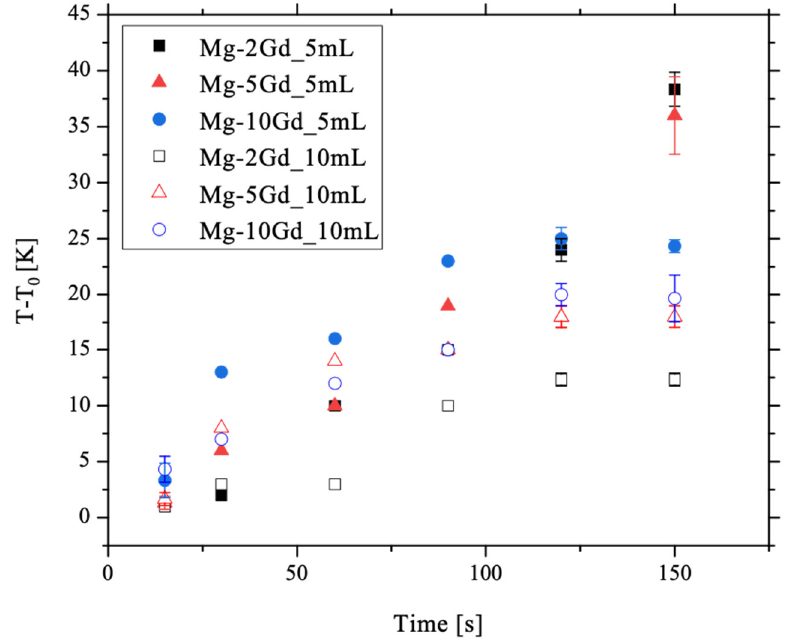
Figure 7. Diagram of T-T 0 plotted against time. T-T 0 increases with increasing time. Temperature increases are greater on etching in 5 mL compared to 10 mL solutions. Mean value and standard deviation of 3 samples were calculated for the time steps 15 s, 120 s, and 150 s.